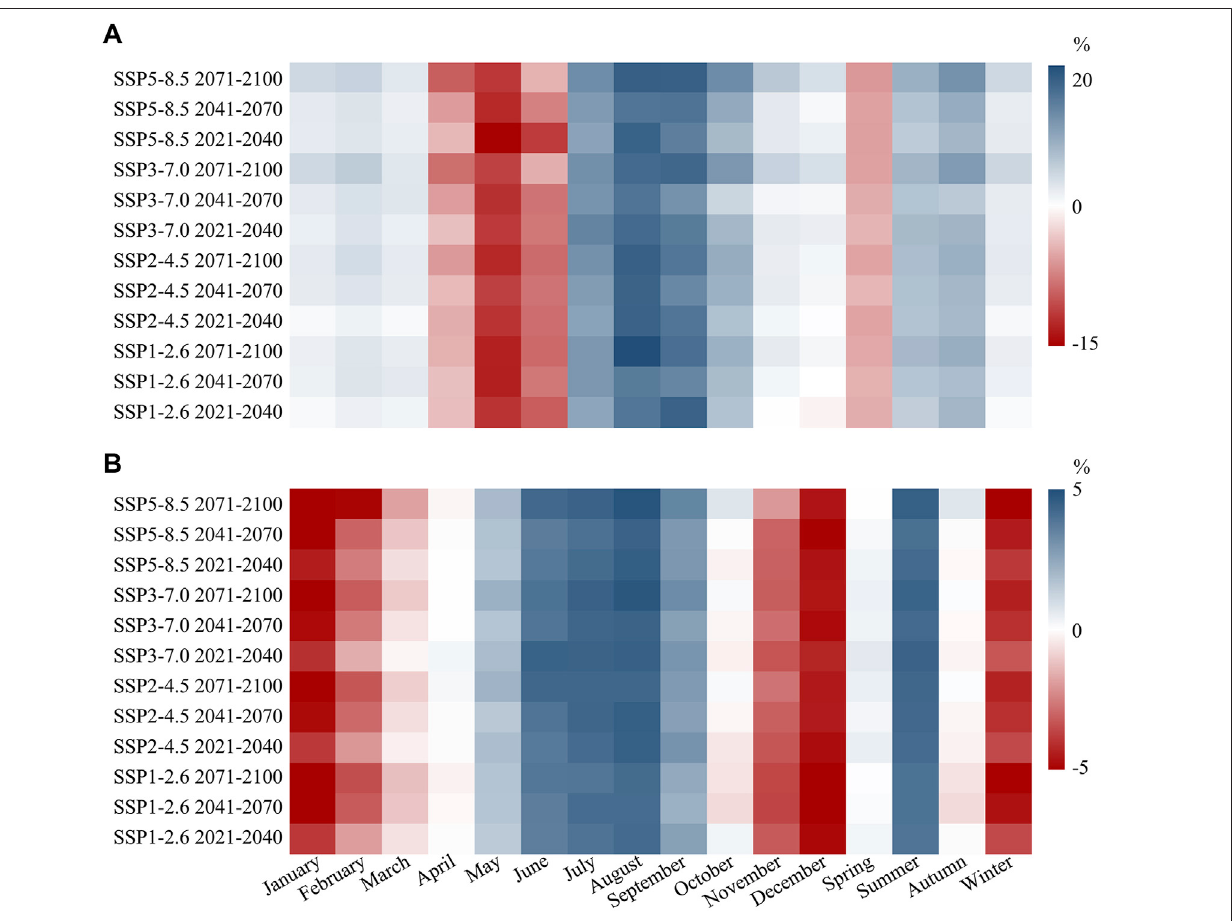
FIGURE8| TheportraitdiagramoftheSSMchangerateoftworegioninChina (A) northof35 ° N (B) southof35 ° N,indifferenttimescalesandfutureperiodsrelative to the historical period (1995-2014)